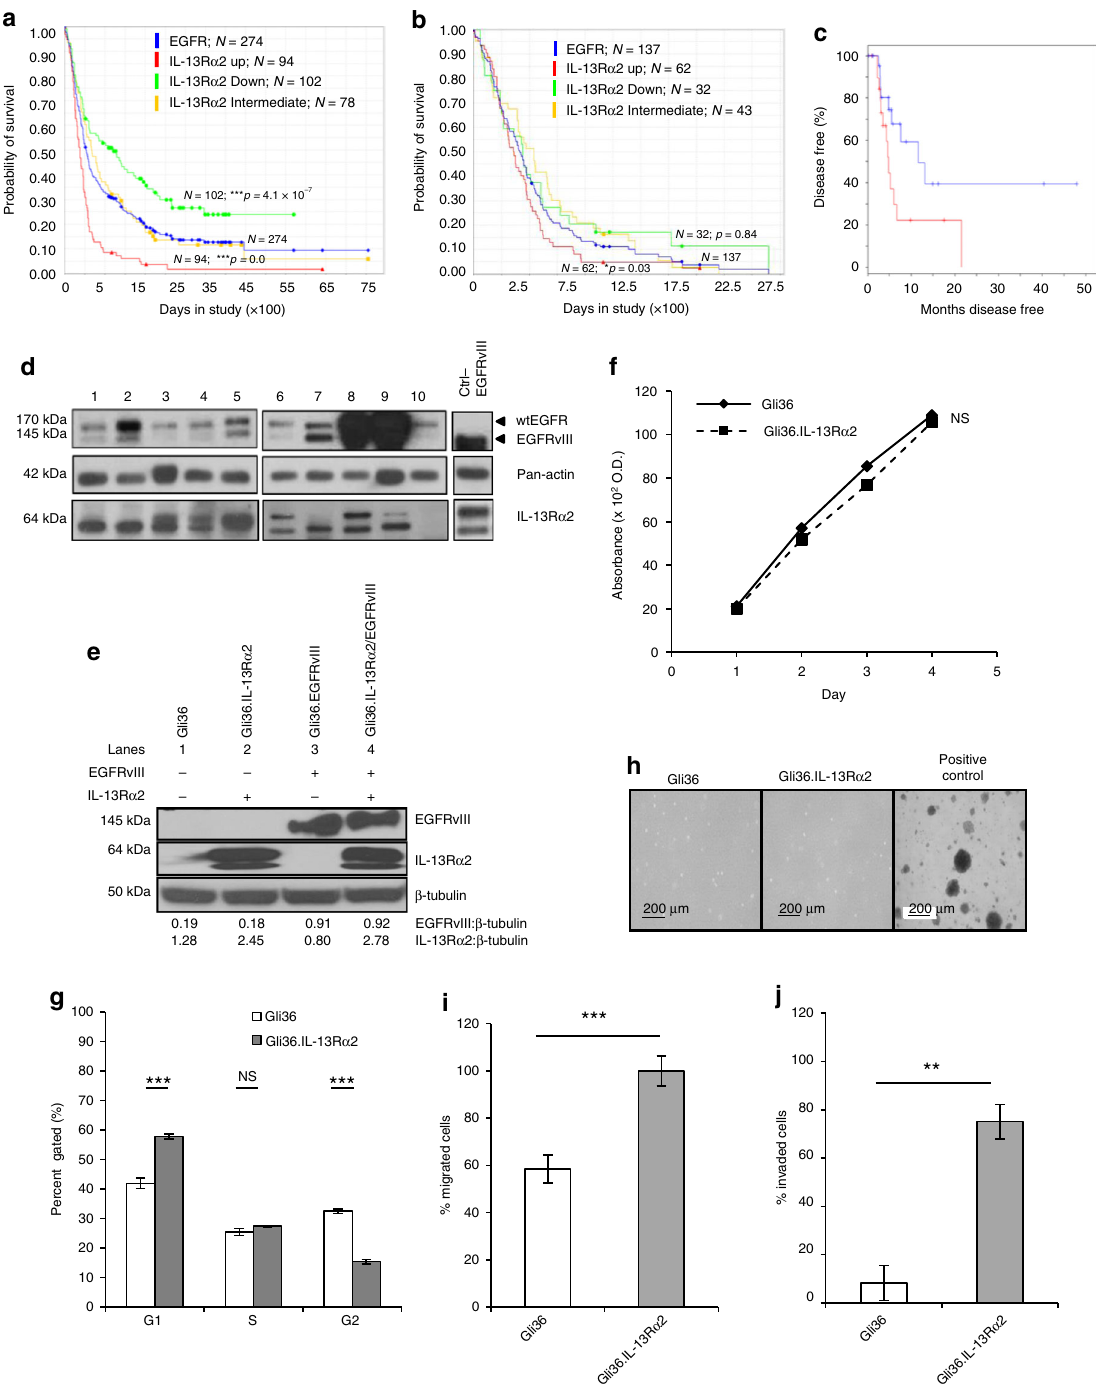
Fig. 1 GBM patients co-expressing EGFR and IL-13R α 2 correlate to poor survival where the overexpression of IL-13R α 2 alone leads to enhance cell migration but not proliferation. Kaplan − Meier survival analysis of a all gliomas patients; b GBM patients from REMBRANDT database from National Cancer Institute (USA). Patients overexpressing EGFR mRNA by 2-fold (blue) with high (red), intermediate (yellow) and low (green) levels of IL-13R α 2 expression were shown. The log-rank p -values were indicated. c Kaplan − Meier survival plots for patients expressing high YKL-40 mRNA levels TCGA. High IL-13R α 2 expression group (red) and low IL-13R α 2 expression group (blue) were determined by aggregating all patients whose z -score normalized expression was above or below 0, respectively (Log-rank test p -value = 0.0374). Immunoblotting analysis showed the expression of EGFR and IL-13R α 2 protein levels were determined from d a panel of 10 patient-derived GBM e and the isogenic cell lines generated from Gli36 glioma cells. Pan-actin or β tubulin served as internal loading controls. f Cell proliferation and g Cell cycle analysis were performed with Gli36 and Gli36.IL-13R α 2 cells h Soft agar colony formation assay was performed, Gli36.EGFRvIII was used as a positive control. i In vitro migration and j invasion assays were determined in Gli36 and Gli36.IL-13R α 2 cells. All data are represented as mean ± SEM, unpaired t -test ** p < 0.01; *** p < 0.001; NS not signi fi